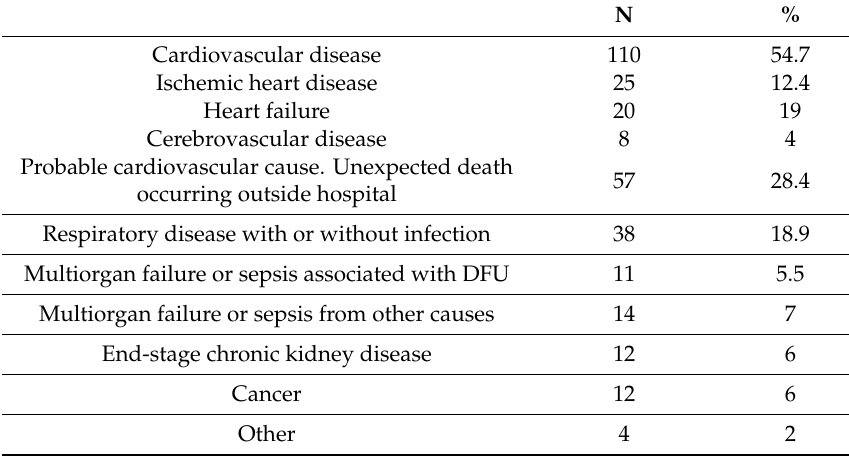
Table 2. Main causes of